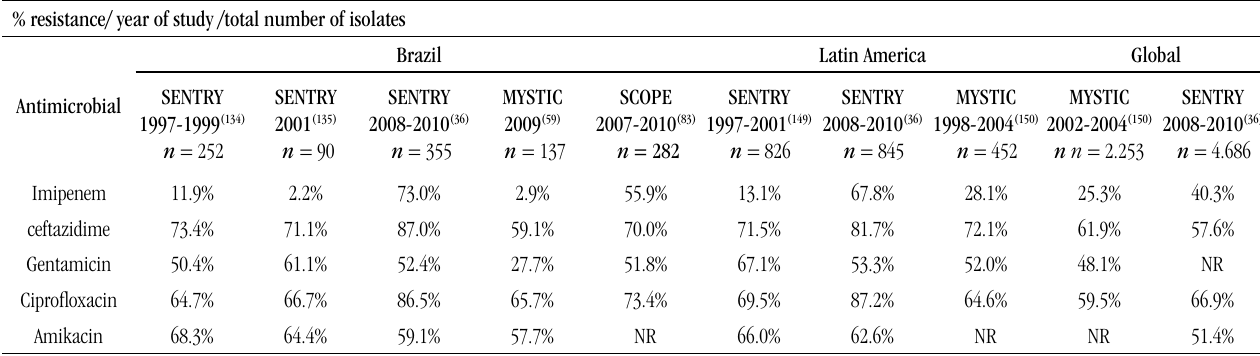
tABLE – Antimicrobial resistance indexes in A. baumannii isolates reported by SENTRY, MYSTIC and SCOPE % resistance/ year of study /total number of isolates Brazil Latin America Global Antimicrobial